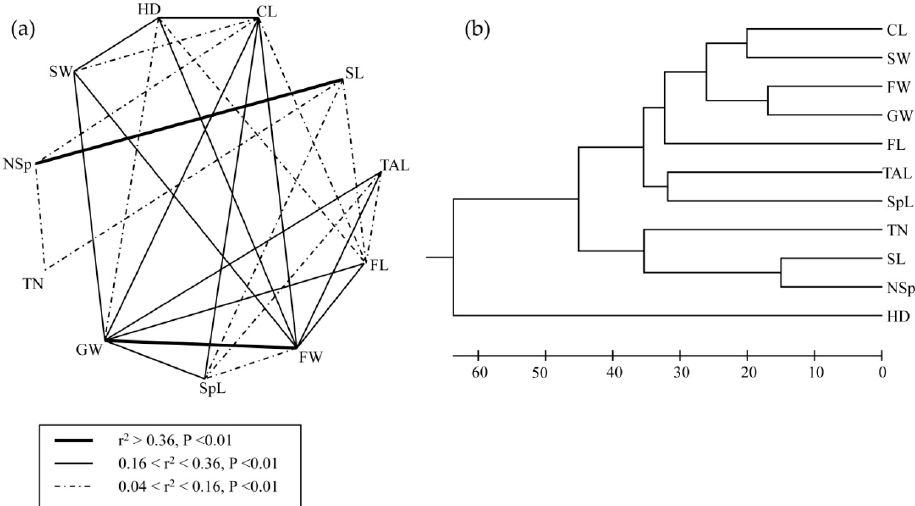
Figure 2. Relationship of the 11 morphological traits. ( a ) The relation based on the Pearson coefficient values. Higher values are connected with thicker lines. ( b ) A dendrogram constructed by the UPGMA method based on the Pearson coefficients. The Pearson values (r) were transformed to the distance values (d) as follows: d = (1 − r)*100.